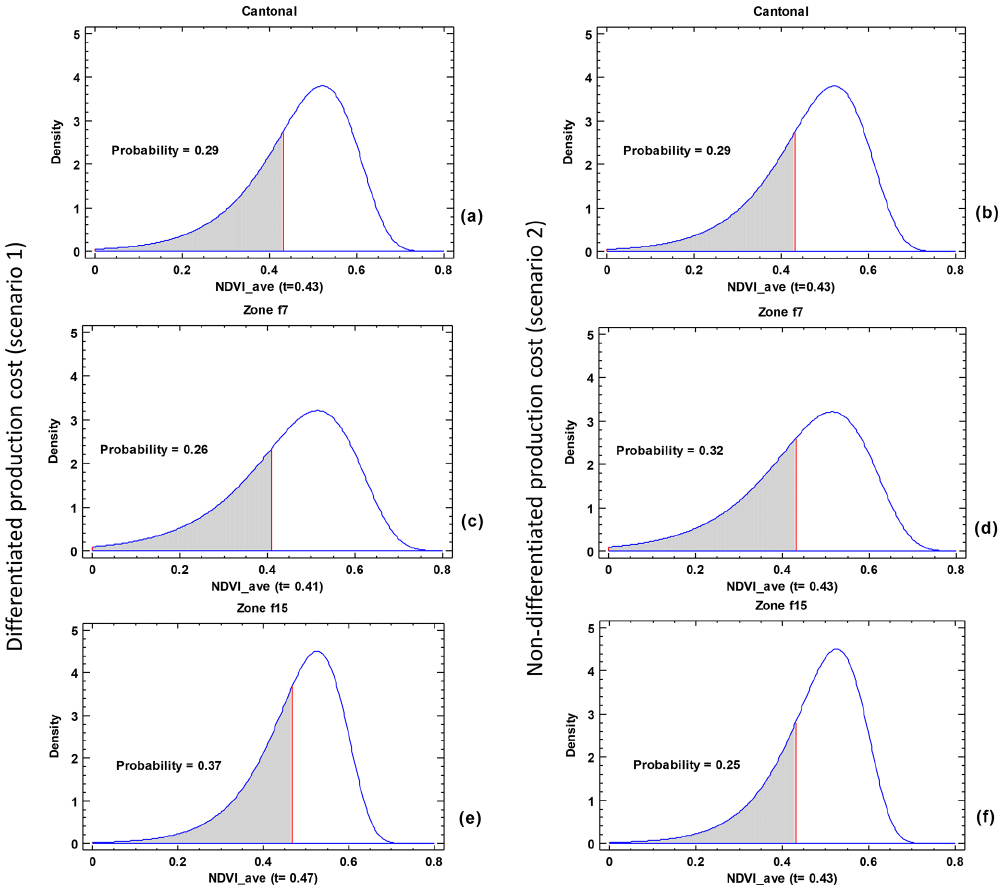
Figure 5. Economic threshold (red line) within generalized-minimum extreme value (GEV min ) distribution of NDVI_ave for differentiated production cost (scenario 1) for (a) cantonal and agro-ecological homogeneous zones (c) f7 and (e) f15 and for non-differentiated production cost (scenario 2) for (b) cantonal and agro-ecological homogeneous zones (d) f7 and (f) f15.